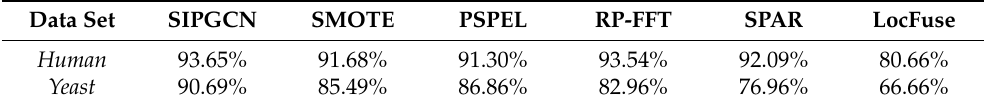
Table 7. Comparison of accuracy among SIPGCN and previous models in the human and yeast data